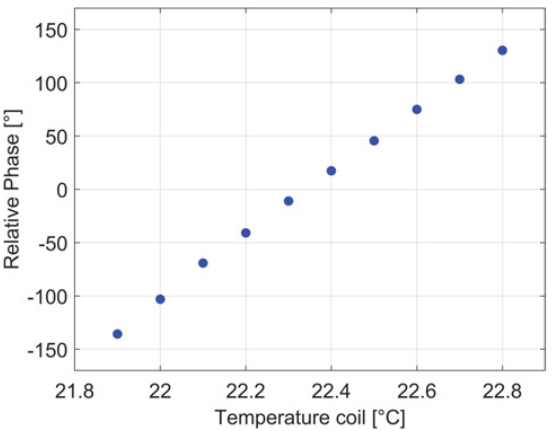
Figure 1. Typical relative phase change in an interferometer when temperature is altered. The phase errors are obtained from a least-squares fit to the interferogram data and are smaller than the symbols of the plot.